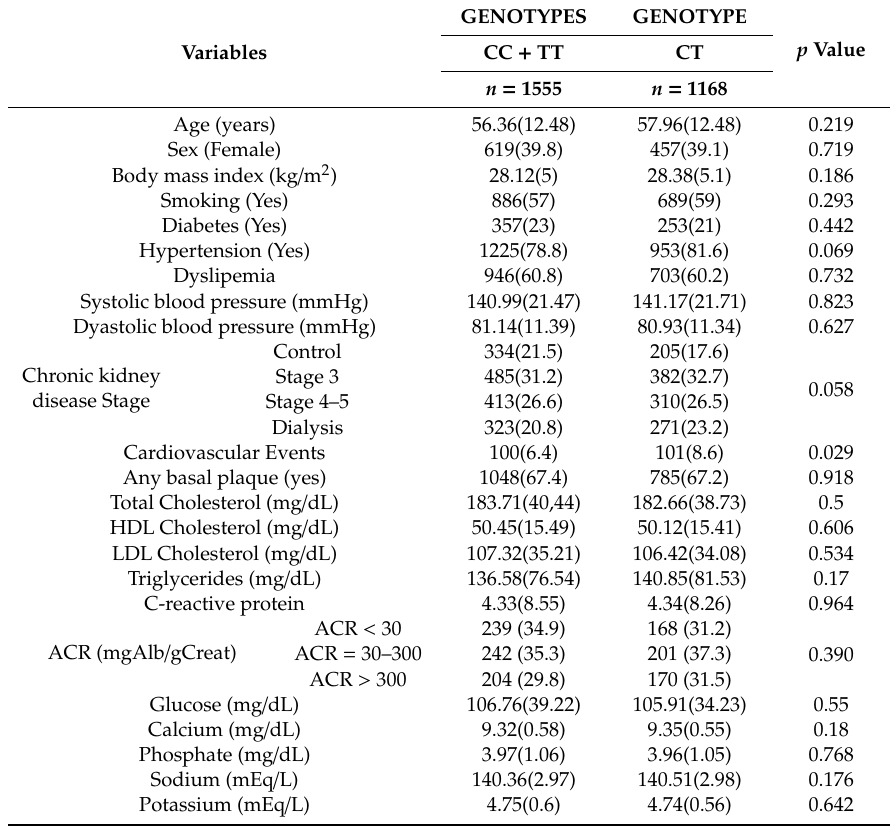
Table 3. Association of SPP1 rs1126616 C > T polymorphism with epidemiological, clinical and biochemical parameters of the cohort.